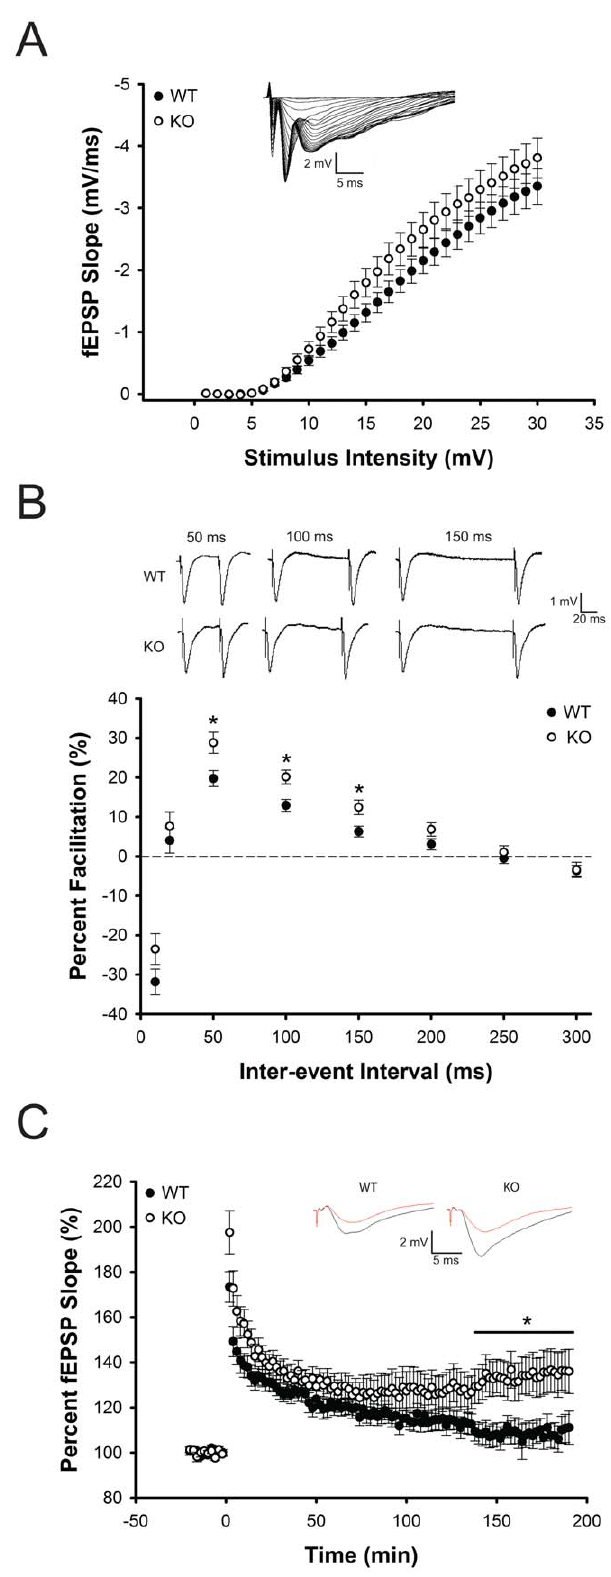
Figure 3. Hippocampal CA1 electrophysiological field record- ings. ( A ) Btbd9 mutant mice showed no differences in input-output relationships. Small inset graph is a representative trace with varying stimulus intensities. ( B ) Btbd9 mutant mice showed enhanced